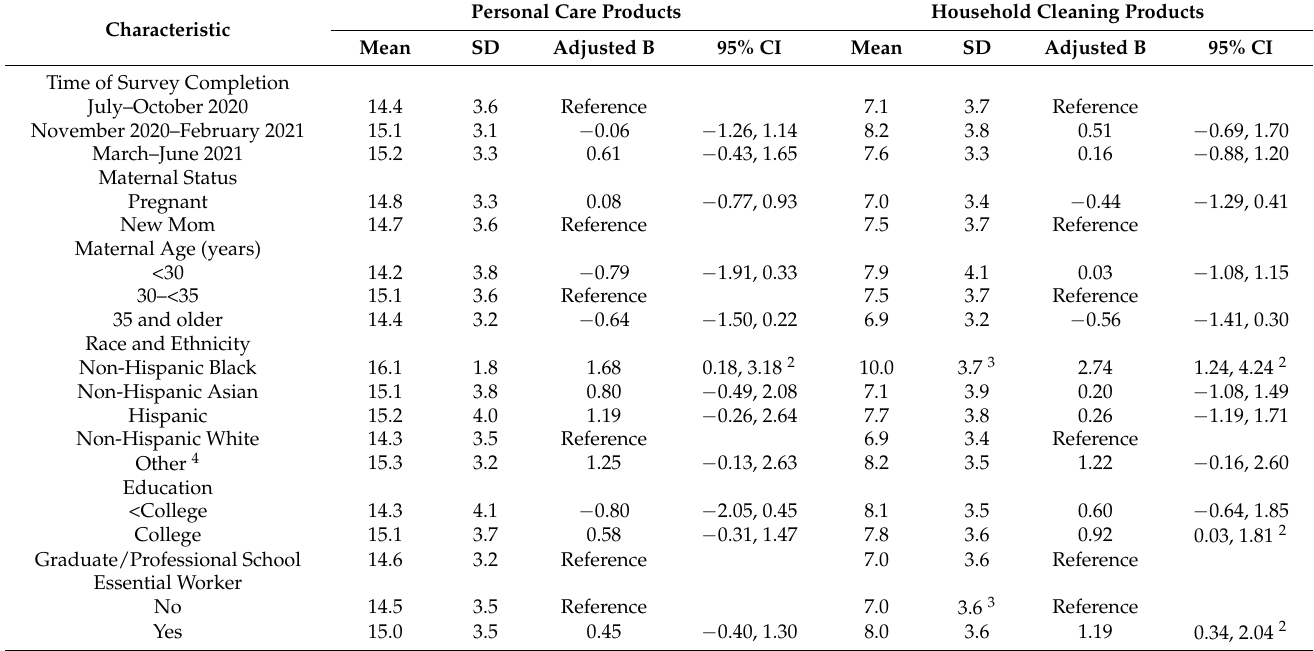
Table 2. Mean (standard deviation, SD) number of types of personal care and household cleaning products and multivariable 1 linear regression analyses estimating adjusted mean differences in number of types of products used during the previous month by selected characteristics among women in the Maternal Health and Behavior Study (n = 320).